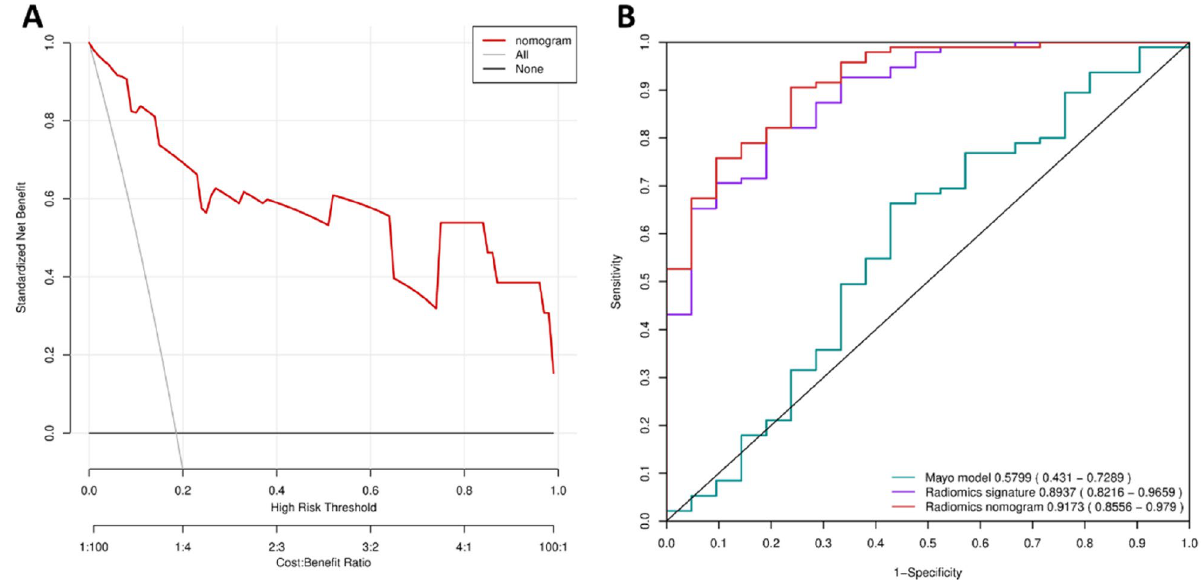
Figure 6. DCA for the radiomics nomogram and the ROC analyses of all 116 patients. ( A ) The y-axis represents the net benefit. The red line represents the radiomics nomogram. The gray line represents the hypothesis that all patients were malignant. The black line represents the hypothesis that no patients were malignant. The x-axis represents the threshold probability. The threshold probability is where the expected benefit of treatment is equal to the expected benefit of avoiding treatment. For example, if the possibility of malignant in a patient is over the threshold probability, then a treatment strategy for malignant should be adopted. The decision curves in the validation set showed that no matter what the threshold probability is, using the radiomics nomogram to predict malignant obtain more benefit than treating either all or no patients. ( B ) Performance of nomogram, radiomics signature and mayo model on all 116 patients. Nomogram adopt radiomics signature and age achieves best predict